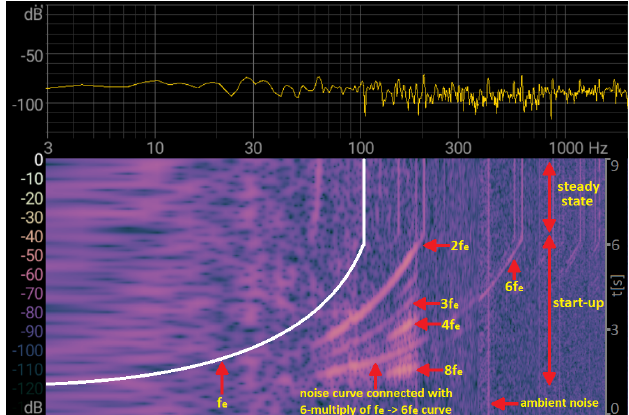
Figure 18. Sound spectrogram measured during start-up ( ω e from 0 to 640 rad applied. Speed ramp 300 rpm